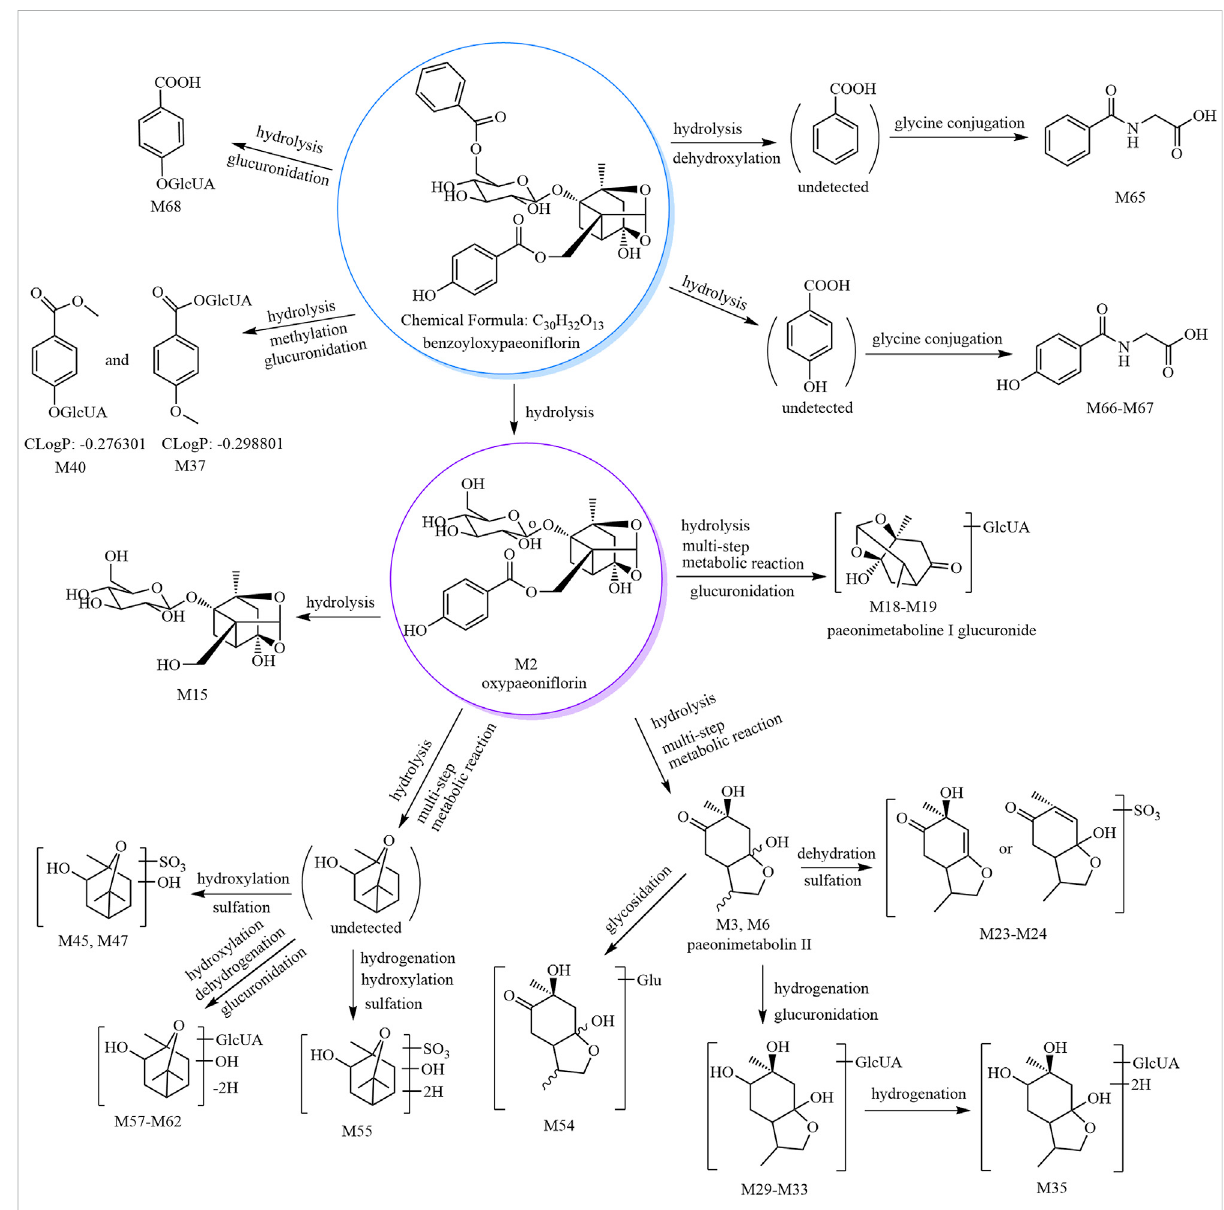
FIGURE 1 The 30 metabolites (all new) and proposed metabolic pathways of benzoyloxypaeoni fl orin in